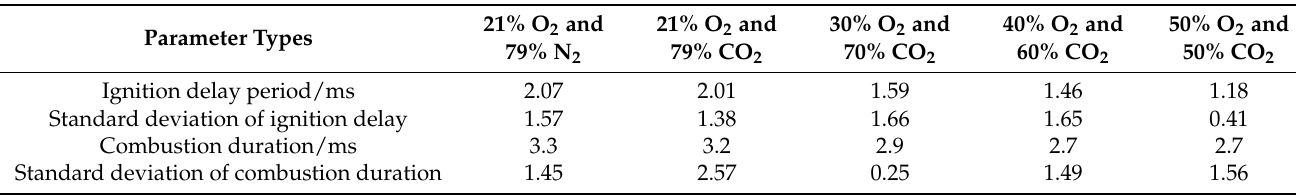
Table 2. Comparison of the ignition delay period and duration of constant volume combustion vessels under nitrogen-free